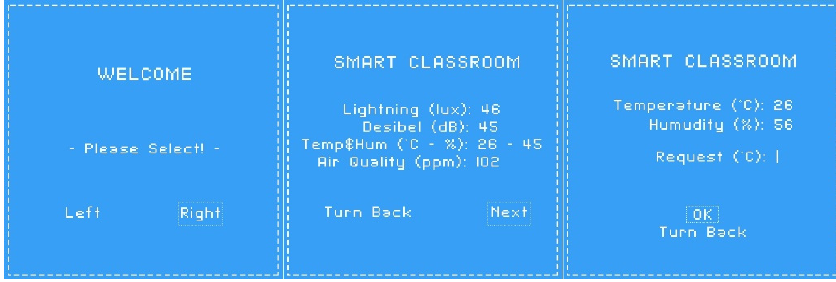
Figure 6. Data box interface.